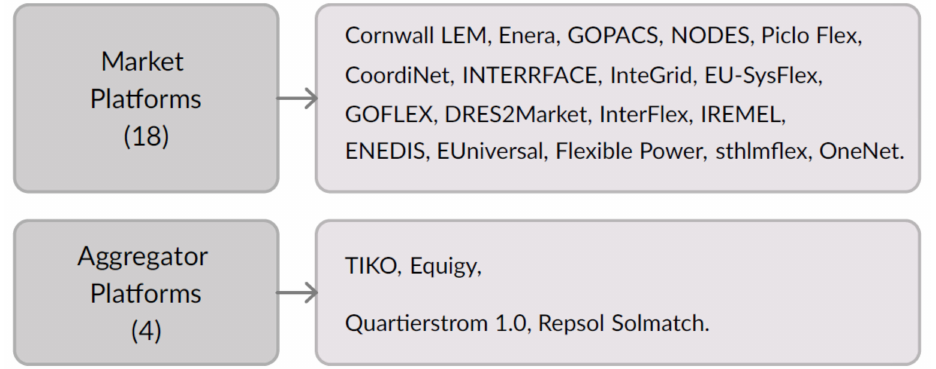
Figure 1. New flexibility market models in